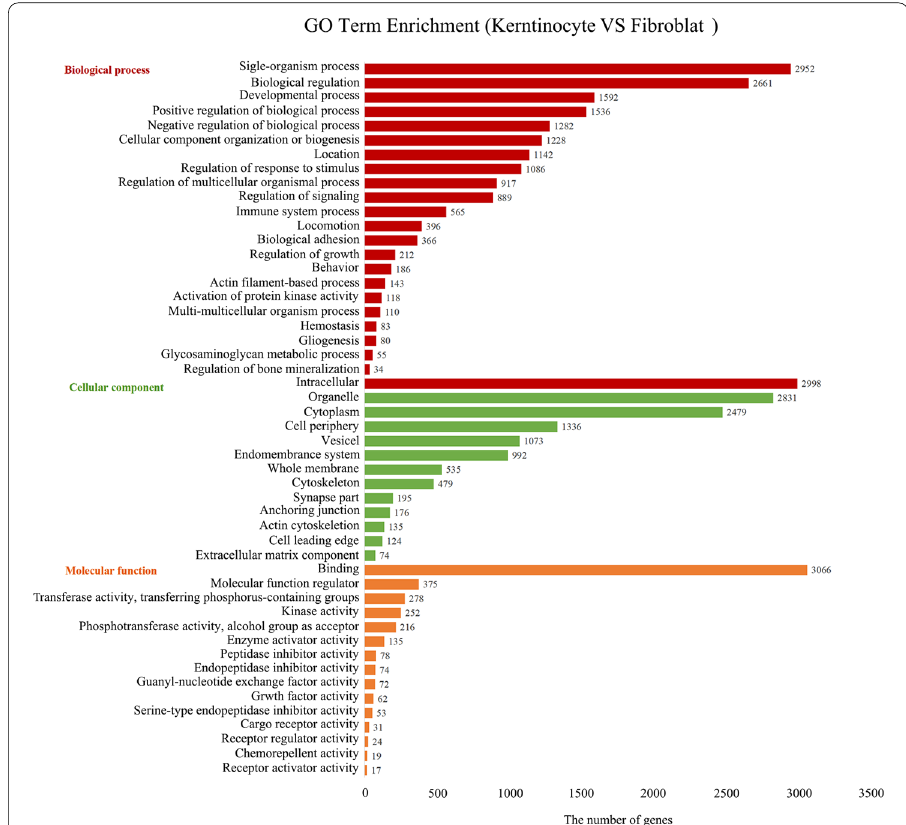
Fig. 3 GO enrichment analysis of DEGs. In order to determine the main biological function of the DEGs, GO enrichment analysis was carried out. The X axis represents the number of differentially expressed genes, and the Y axis represents the category (biological process, cellular component, and molecular function). Each column represents a subcategory of the corresponding